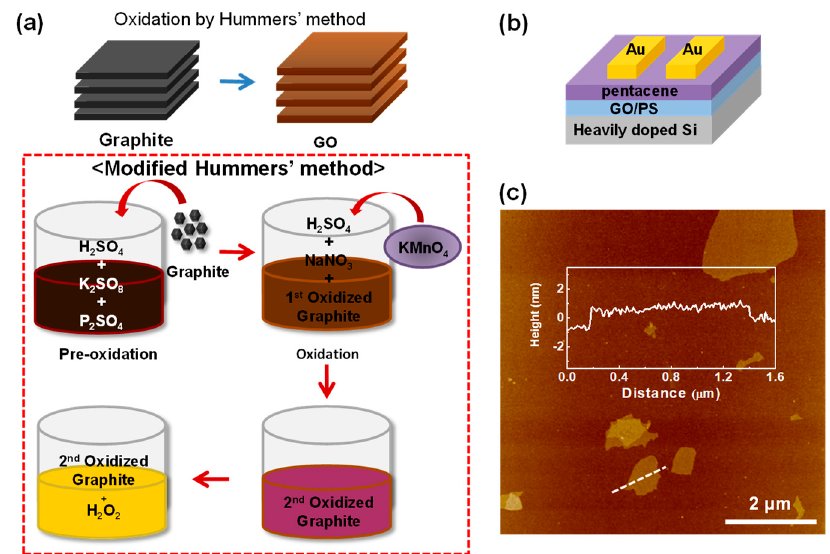
Figure 1. ( a ) Schematic illustration of procedure for synthesizing graphene oxide (GO) by modified Hummers’ method. ( b ) Schematic device structure of organic field-effect transistor (OFET) used in this study. ( c ) Height-mode atomic force microscopy (AFM) topographs of GO pieces obtained from highly diluted solution (the inset shows the height profile of a GO slice).